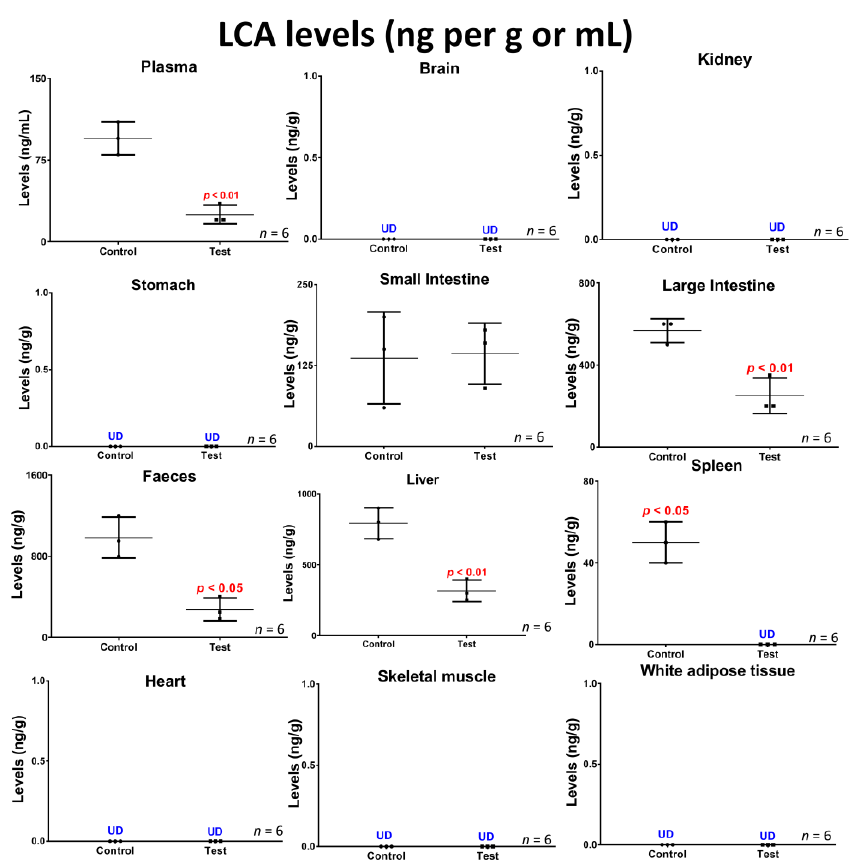
Figure 5. LCA concentrations in plasma, brain, kidney, stomach, small intestine, large intestine, faeces, liver, spleen, heart, skeletal muscle, and white adipose tissue in control and treatment groups. Data are the mean ± SEM.